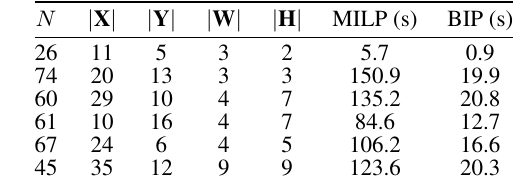
Table 4. Comparison of the runtime between MILP and the proposed BIP approaches. The second to fifth columns demonstrates the complexities of the model